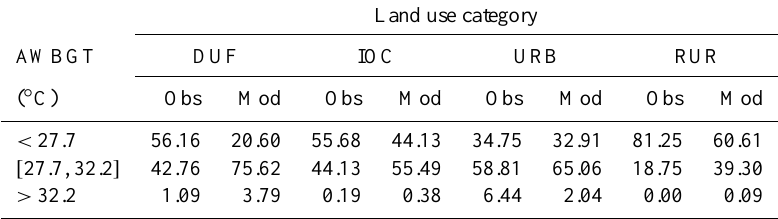
Table 5. Same as Table 4, but for